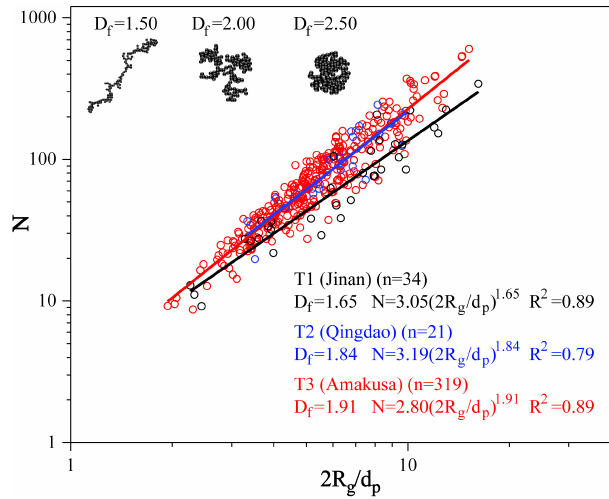
Figure 4. Relative abundance of three types of soot-bearing aerosol particles at the three sampling sites. The number of analyzed soot- bearing particles is shown above the column.